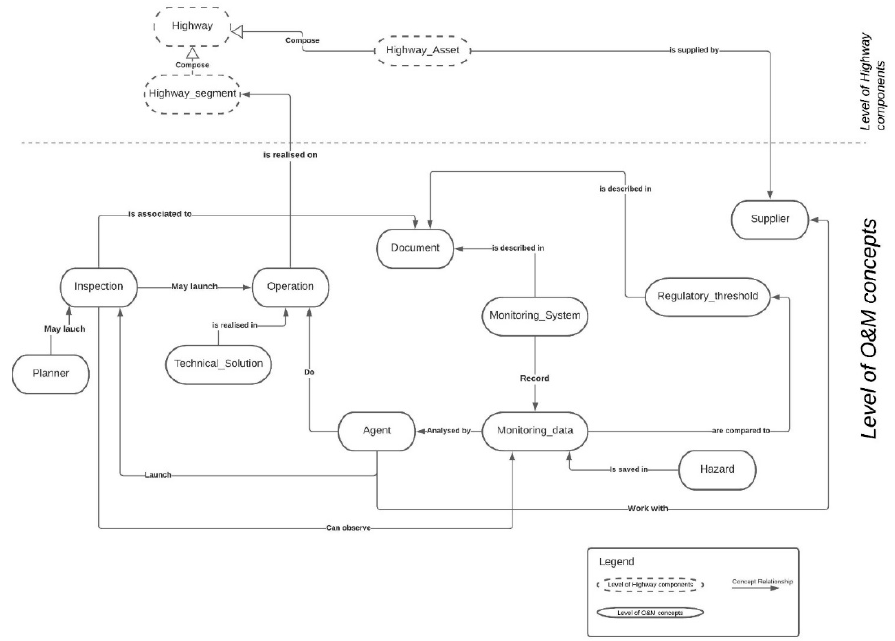
Figure 4. IFCInfra4OM Ontology Definition Schema.